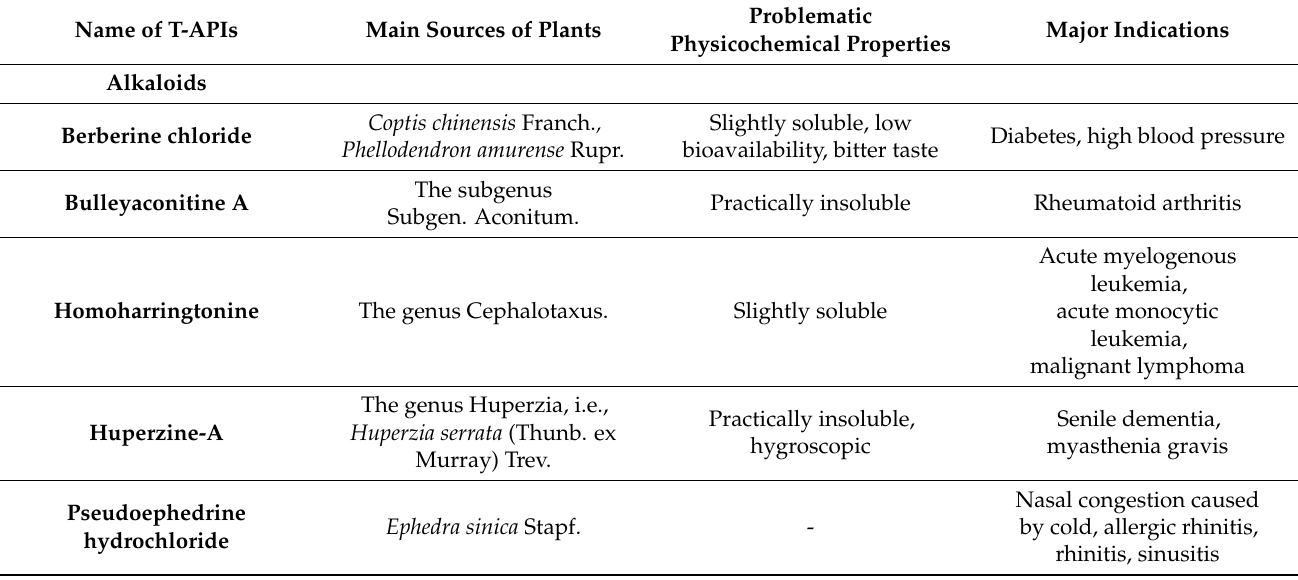
Table 2. Sources of plants, physicochemical problems, and major indications of T-APIs, including alkaloids,